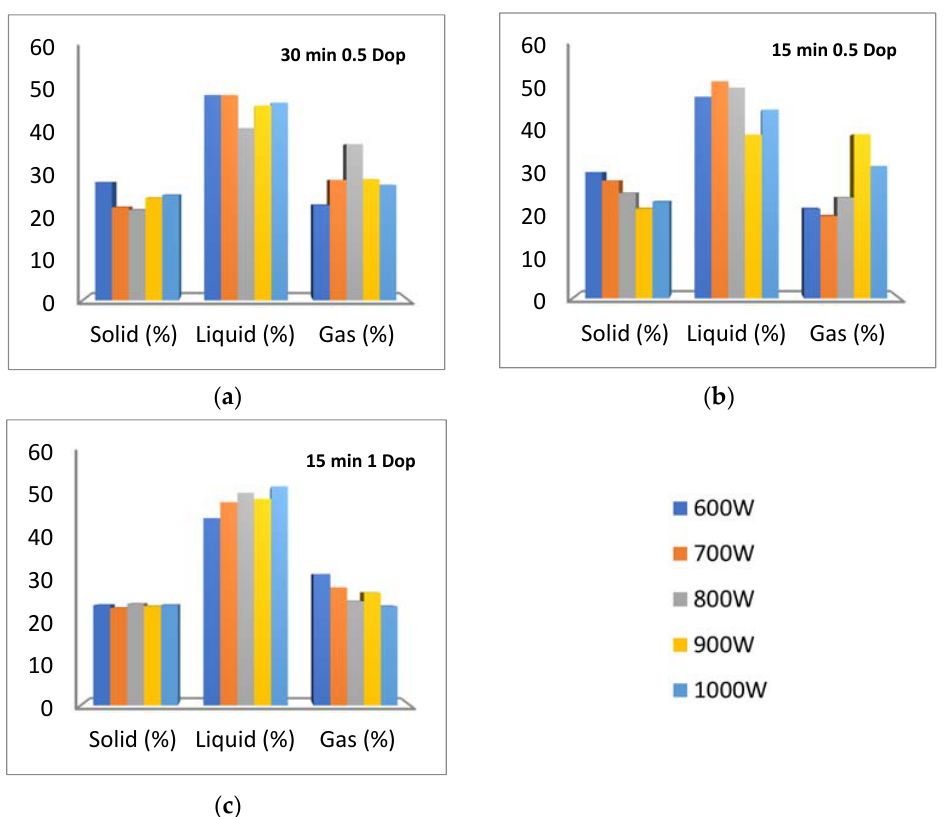
Figure 4. Comparative mass balance for the pyrolysis of leather waste tanned with vegetable tannins: ( a ) 30 min 0.5 g Dop; ( b ) 15 min 0.5 g Dop; ( c ) 15 min 1 g Dop.